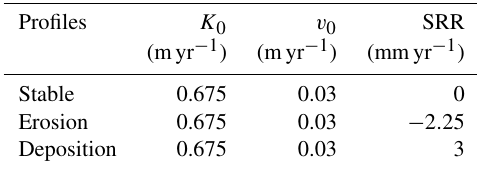
Table 4. Calibrated optimal parameter values for the USA study site. K d and v d were set to be 0.01m − 1 in the model calibration. The parameter values for SOC cycling are listed in Table 1. SRR indicates the soil redistribution